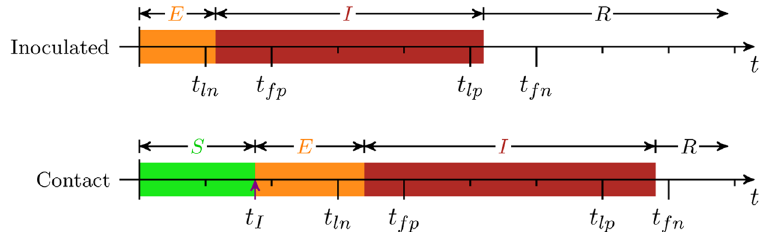
Figure 1. Schematic of the data and model. Animals are classified according to whether they are susceptible ( S ), exposed (i.e. infected but not yet infectious) ( E ), infectious ( I ) or recovered ( R ). The data provide the times of last negative, t ln , and first positive, t fp , samples, which provide constraints on the inferred infection time, t I , and latent period, E . Similarly, the times of last positive, t lp , and first negative, t fn , constrain the infectious period, I